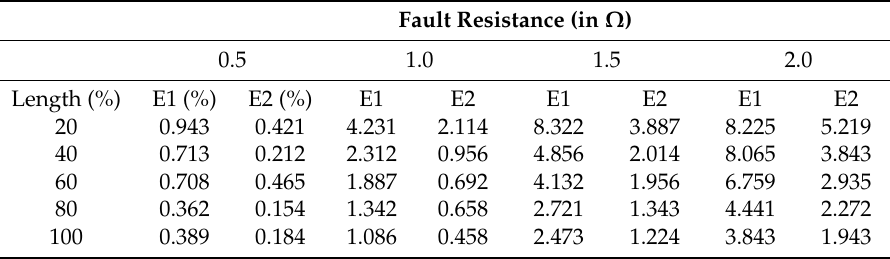
Table 2. Comparison of two different methods under same fault conditions